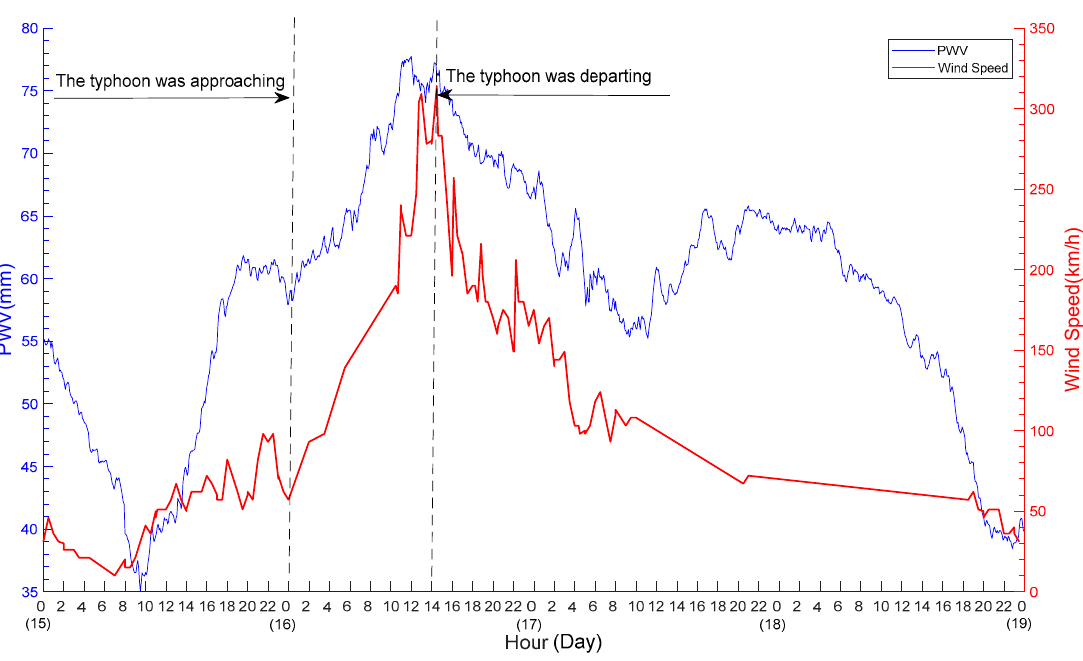
Figure 13. Time series of PWV (blue) over the HKSL station and wind speed (red) over the anemometer station during the four-day period of 15–18 September (both stations are close).